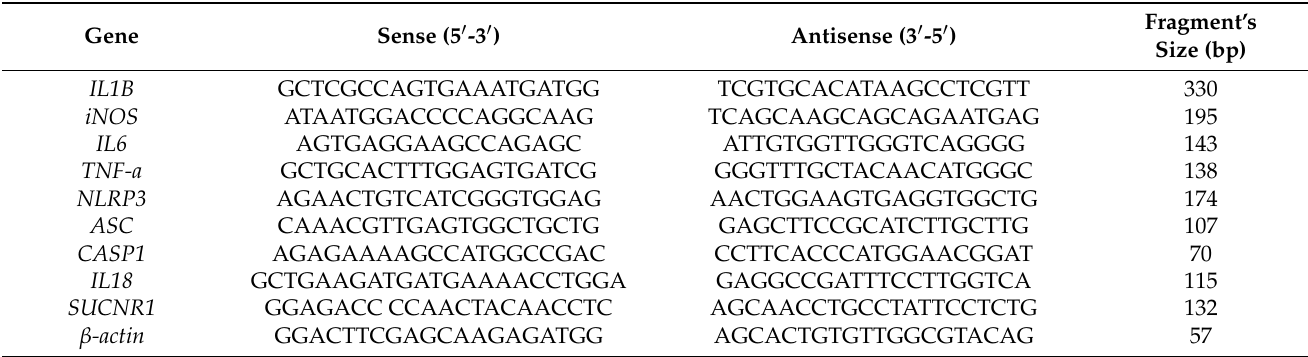
Table 3. Sequences of human primers used in real-time PCR.